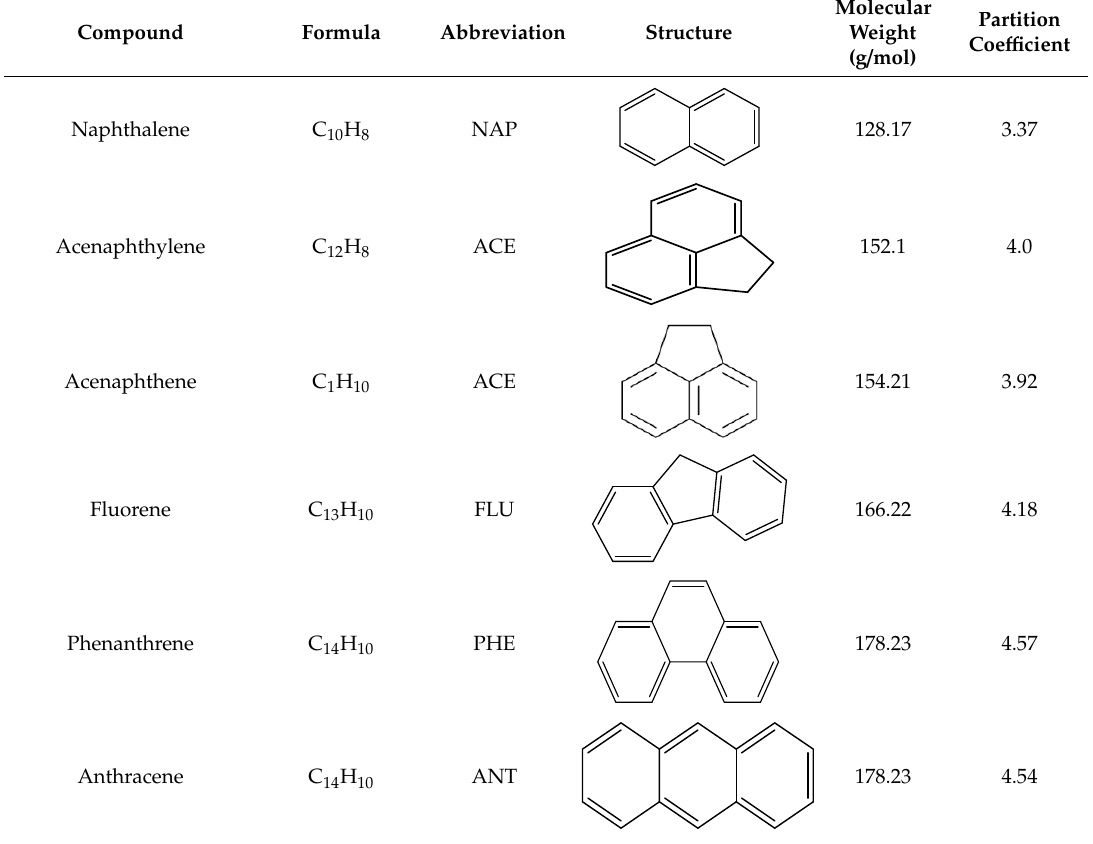
Table 1. Chemical structures and log p values of polycyclic aromatic hydrocarbons (PAHs). Compound Formula